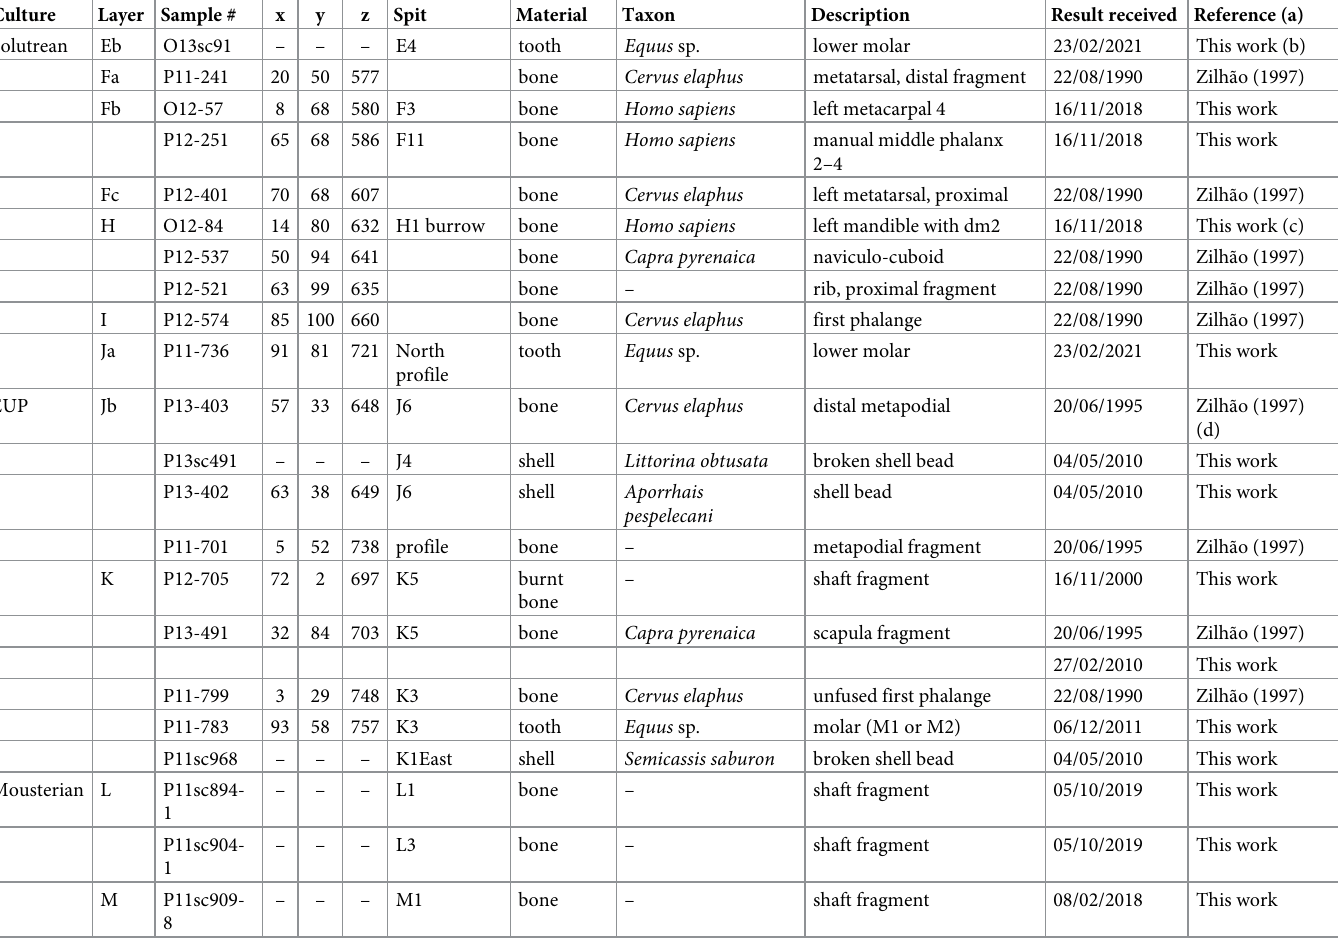
Table 4. AMS radiocarbon dating of the Pleistocene deposit in back chamber, corridor, and entrance: Samples.